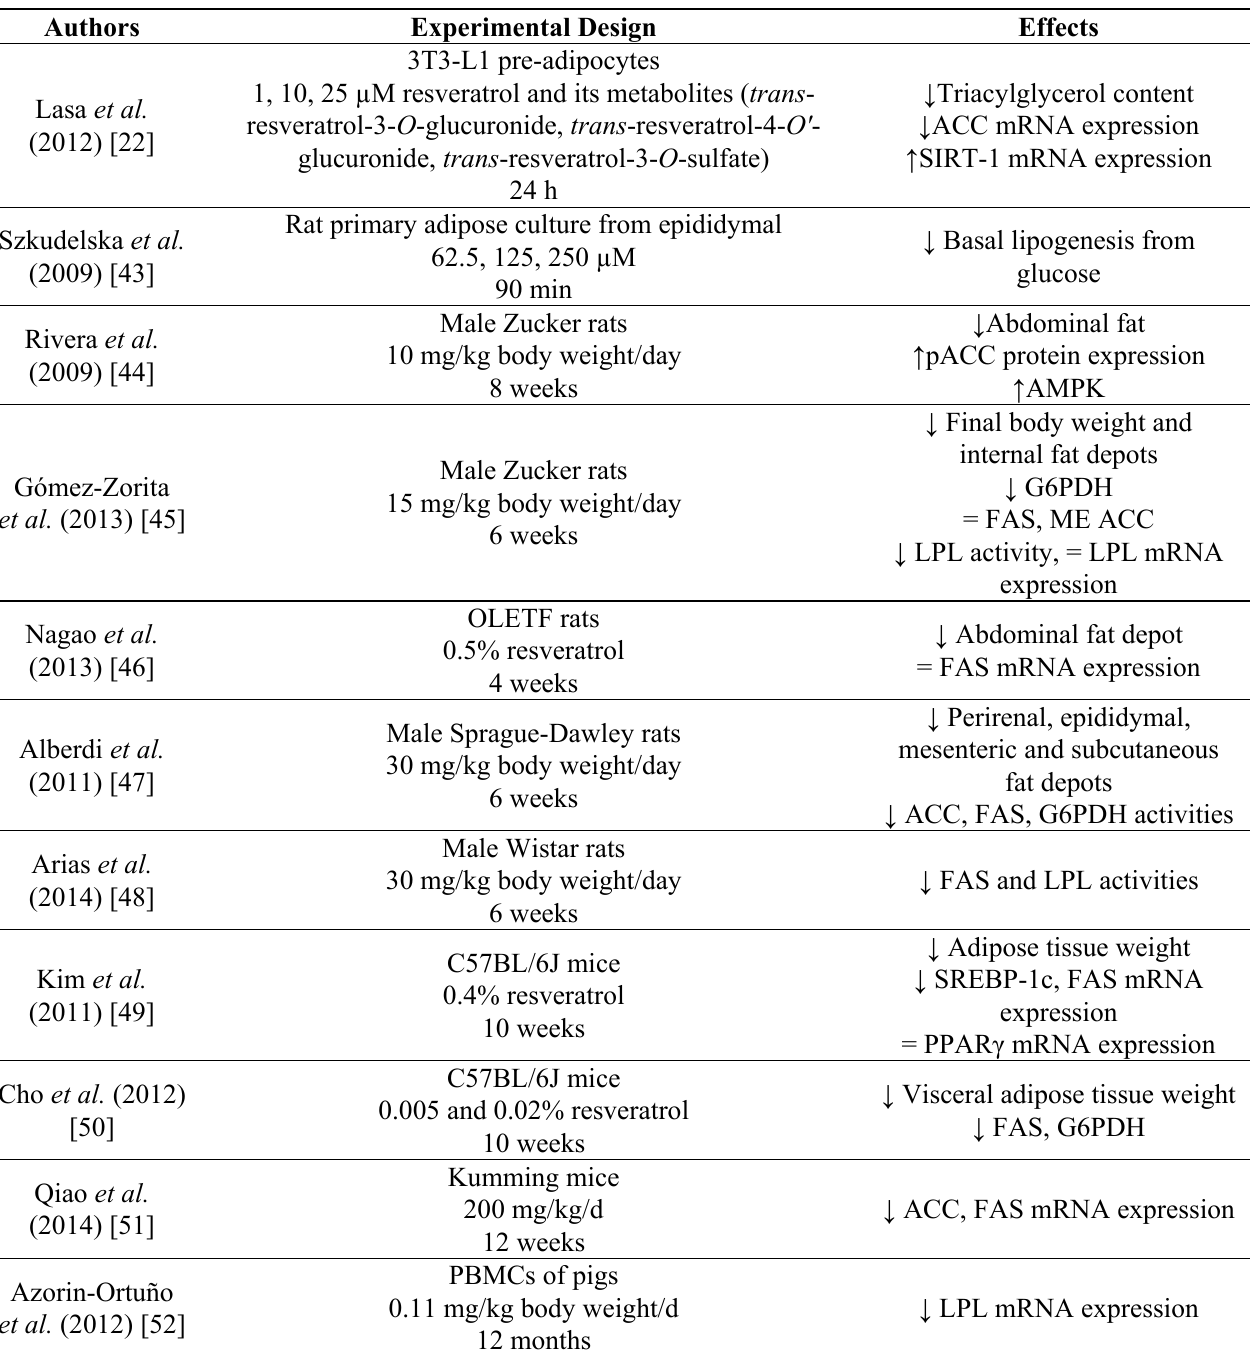
Table 3. Effects of resveratrol on de novo lipogenesis and lipoprotein lipase in in vitro and in vivo